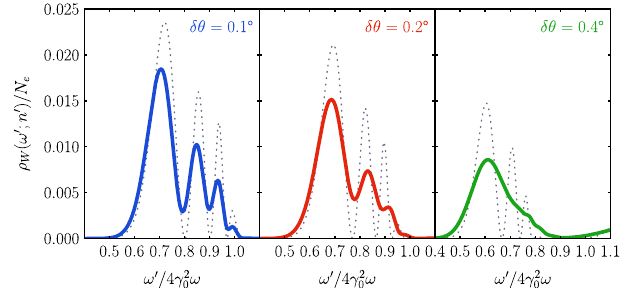
FIG. 4. Warm spectral density for an electron incidence angle (cid:6) 0 ¼ 10 (cid:9) relative to the laser beam (as in the left panel of Fig. 3), but at a slightly different observation direction given by the angles (cid:15)(cid:3) ¼ (cid:3) (cid:1) (cid:6) 0 and (cid:4) ¼ ’ 0 ¼ 0 . As a comparison, the results for the respective cold spectral density are also shown as dotted curves in each panel. All other parameters are the same as in Fig.